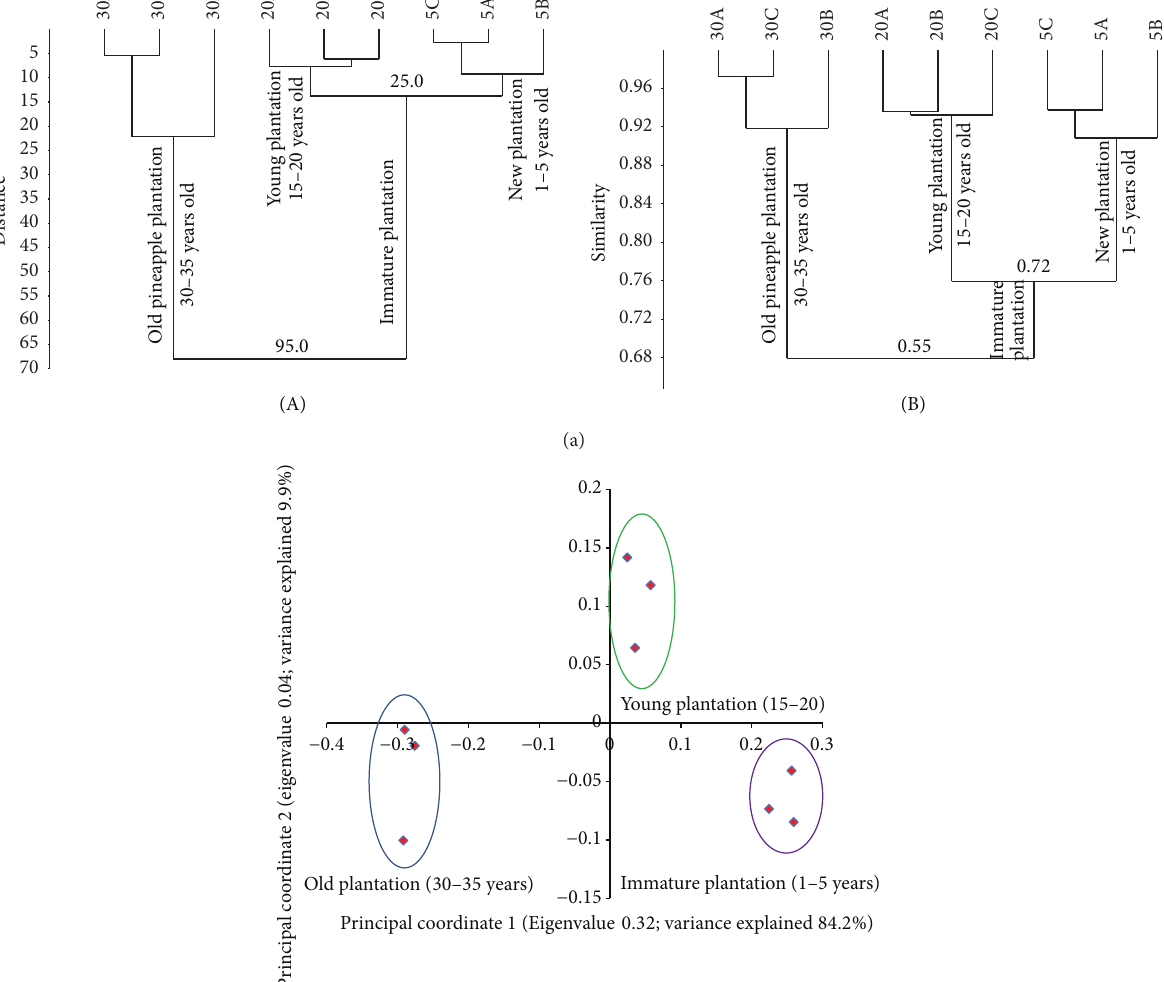
spatial distribution of earthworm communities (Figure